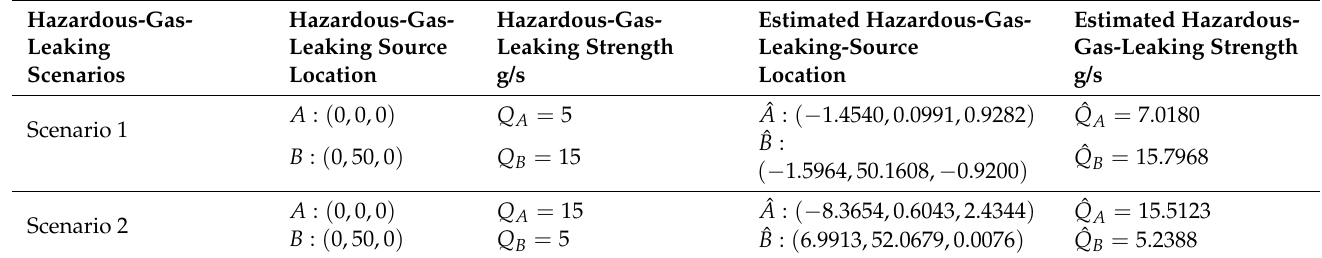
Table 4. Offline STE results obtained in Step